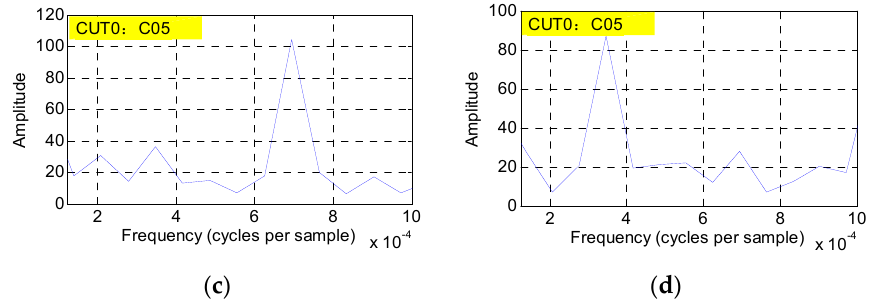
Figure 13. The magnitude spectrum of satellites C03 ( a,b ) and C05 ( c,d ) at stations CUT0 ( a,c ) and JFNG ( b,d ).